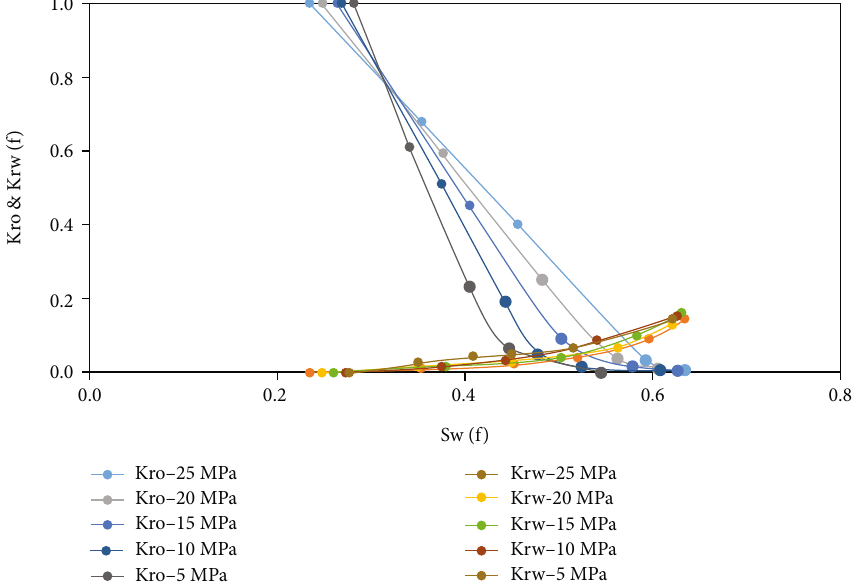
Figure 6: Oil-water phase permeation curves under di ff erent formation